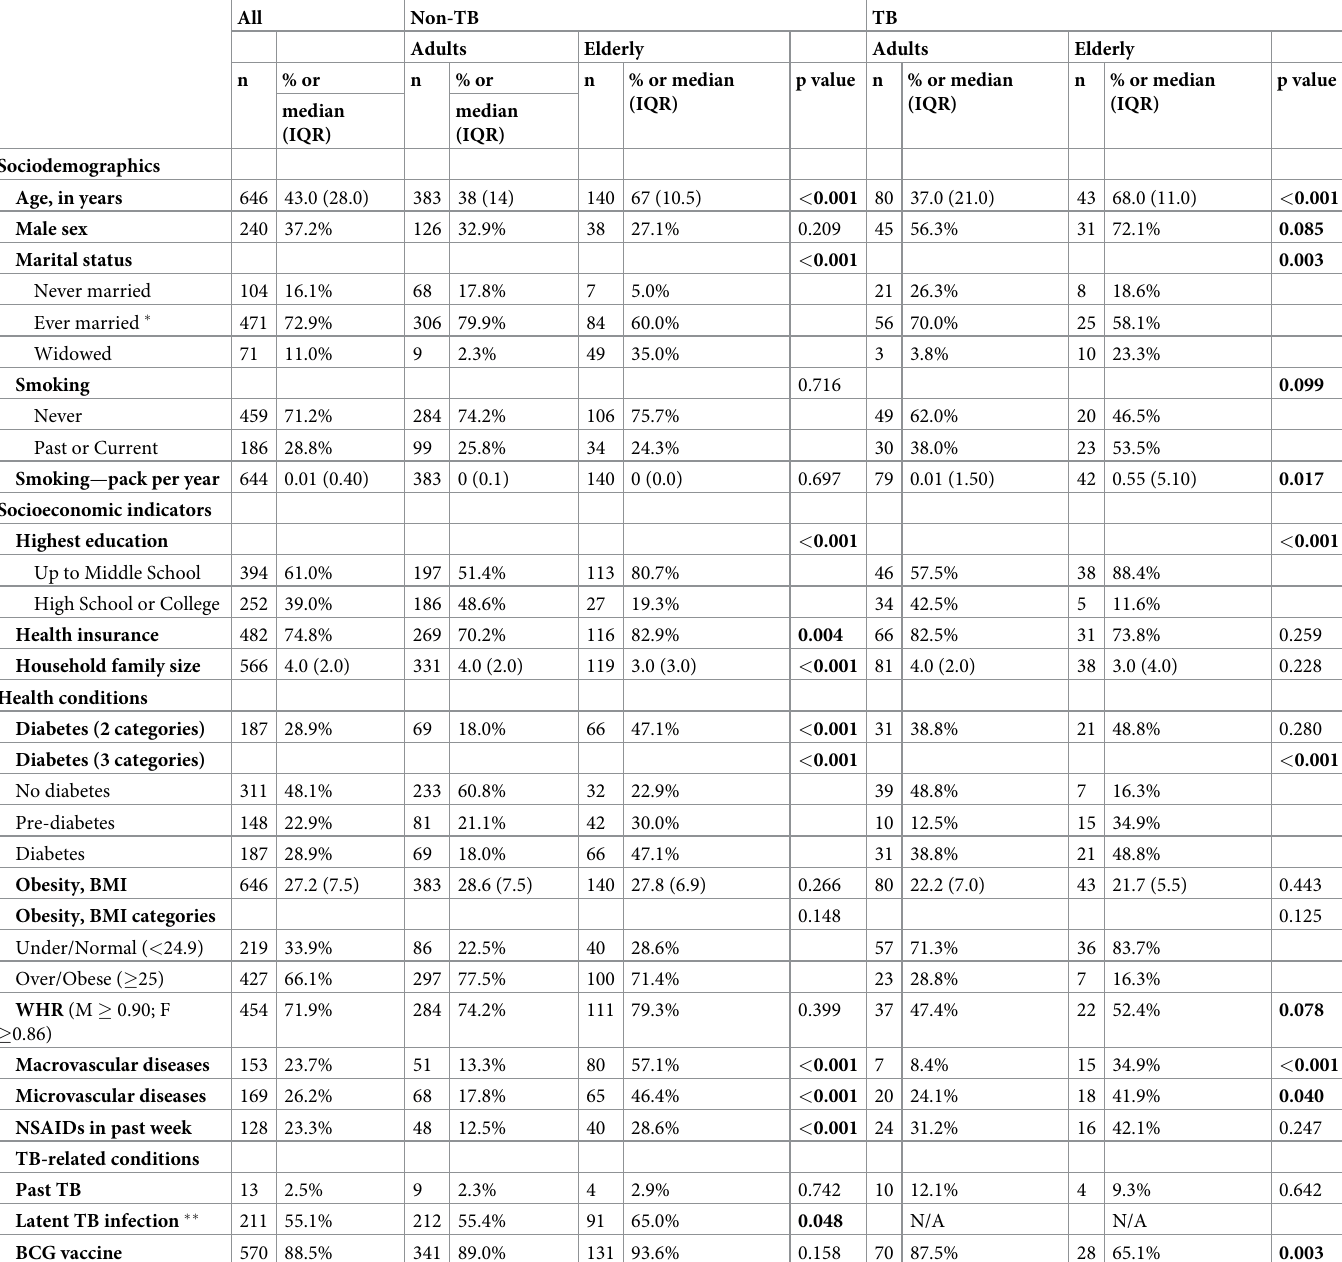
Table 1. Characteristics of the elderly vs . adults, by TB study